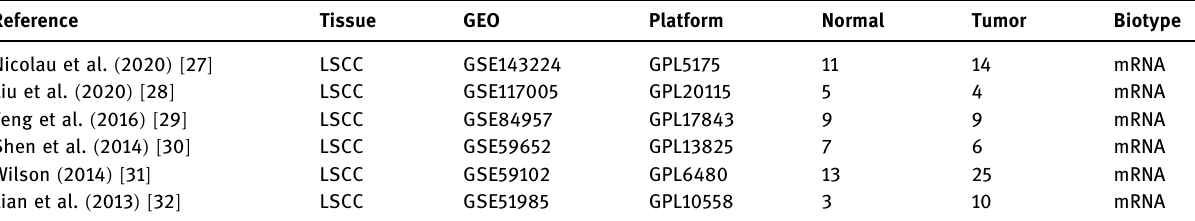
Table 4: Details of the Gene Expression Omnibus ( GEO ) LSCC data sets